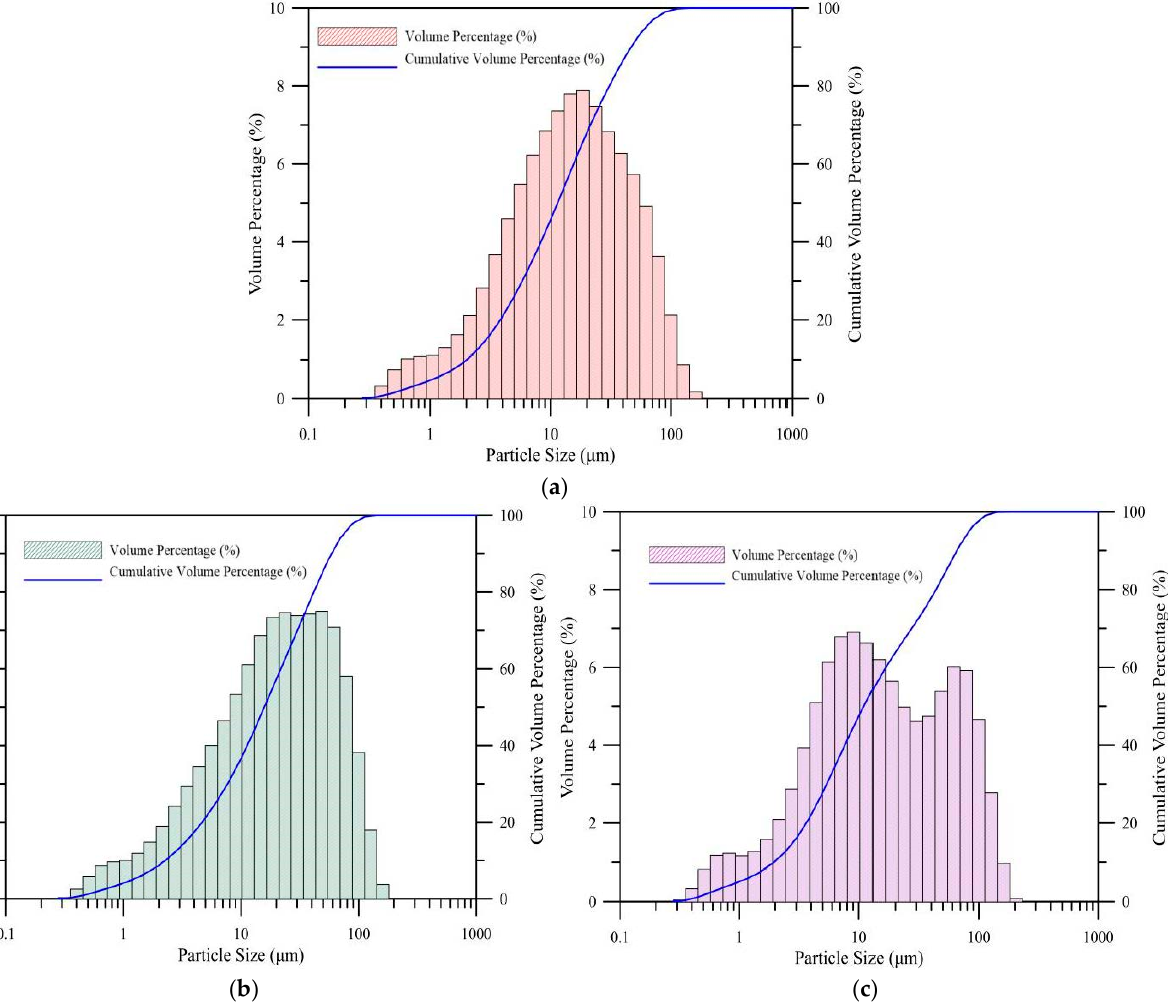
Figure 2. Particle size distribution of fly ash obtained from a laser diffraction particle size analyzer.